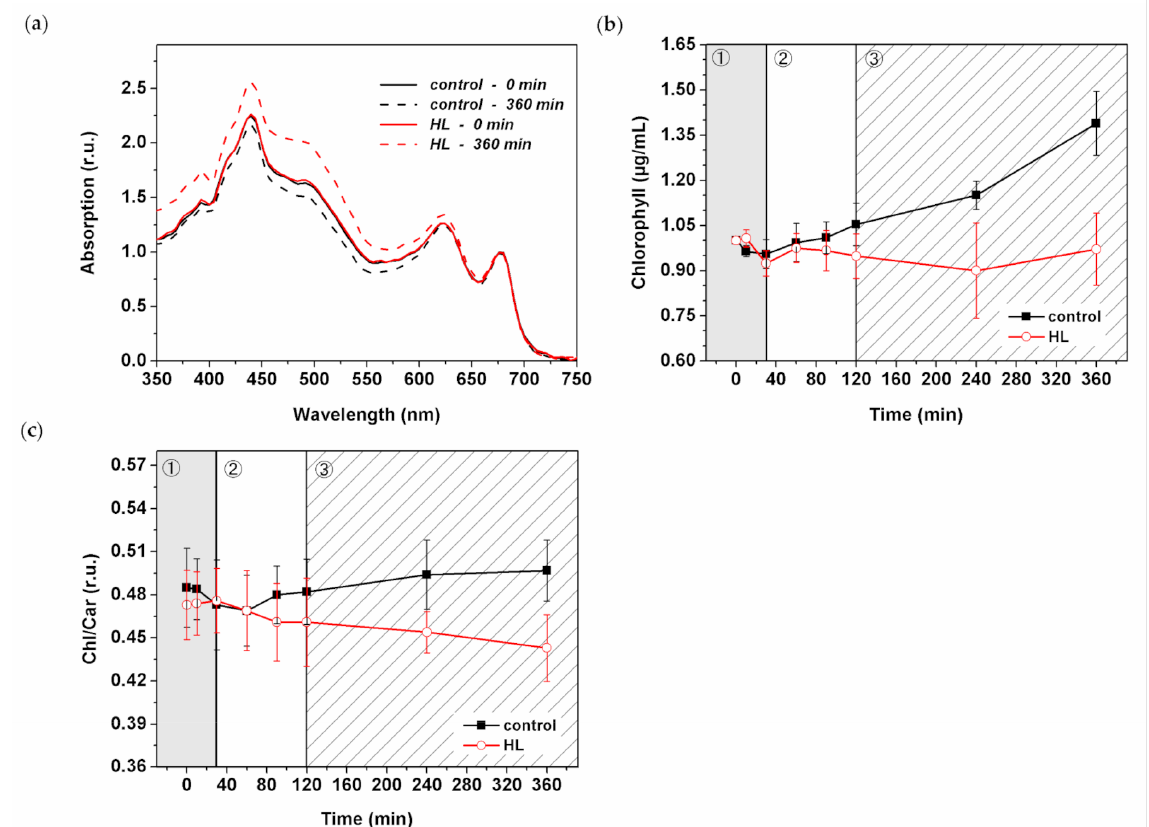
Figure 6. Spectroscopic and HPLC analysis of pigment composition during HL treatment of Synechocystis PSI - YFP cells. ( a ) Absorption spectra. Data were normalized to the peak corresponding to PSII (664–665 nm). Straight black line = control time 0 min; dashed black line = control 360 min. Straight red line = HL time 0 min; dashed red line = HL time 360 min. Average of four independent biological measurements. ( b ) Chlorophyll concentration was estimated spectroscopically according to Ritchie et al. (2006). Black line = control; red line = HL. Data represent average of four independent biological measurements that are normalized to time 0 min. ( c ) Chlorophyll/total carotenoids ratio was estimated based on HPLC analysis. All detected carotenoids were taken into consideration, n = 4. Black line = control; red line = HL. Presented HPLC data represent averages and SDs of four independent biological measurements. The three phases of cyanobacterial cell response to HL (see Konert et al. (2019) [5]) are marked by different background colors and numbers (grey—fast response; white—intermediate phase; striped—acclimation